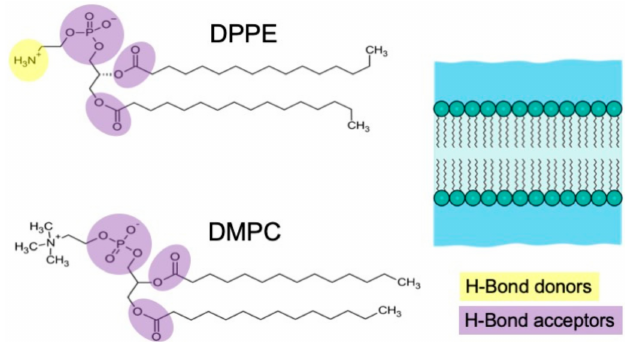
Figure 1. Chemical structures of DPPE and DMPC lipids are reported together with a schematic illustration of a fully hydrated bilayer structure. Functional groups that are H-bond donors (acceptors) are colored in yellow